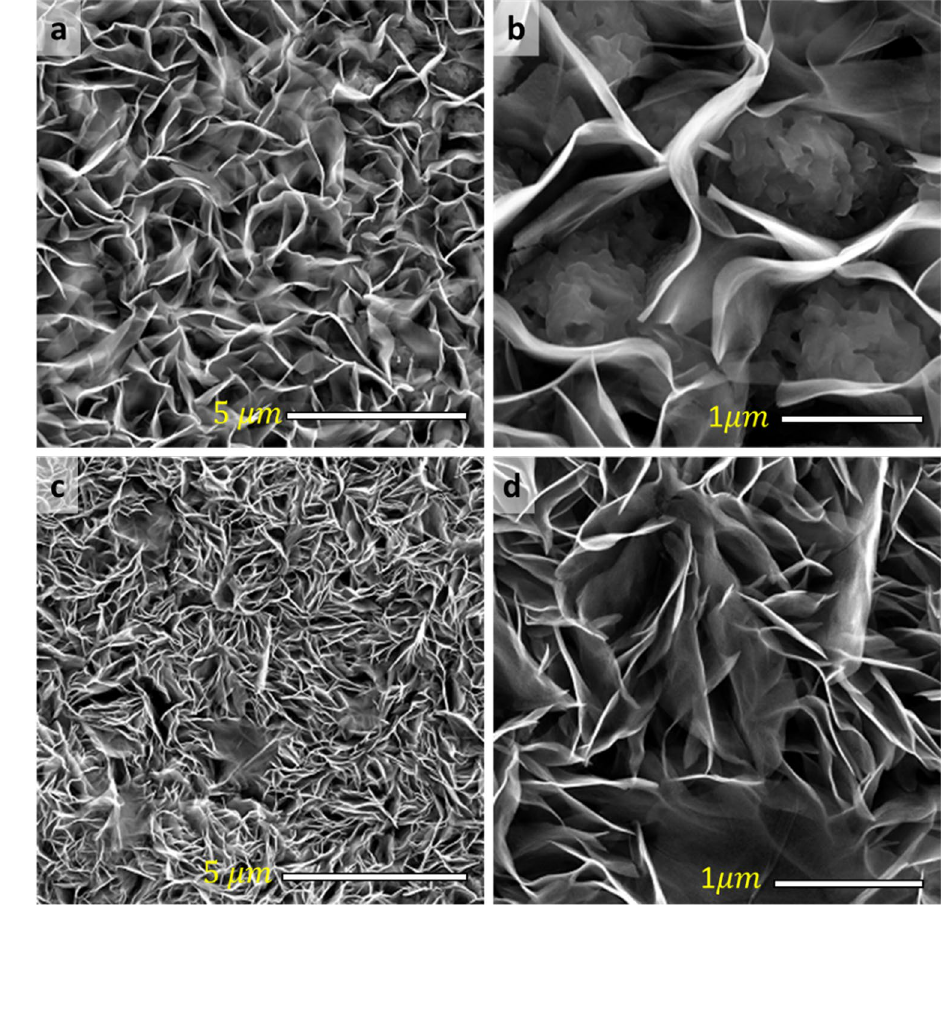
Fig. 2 Surface morphology and nanostructures at different microscale of a , b NiCo and c , d NiCo